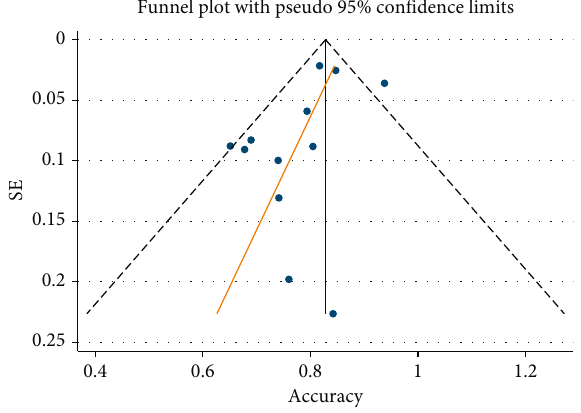
Figure 5: Funnel plot of